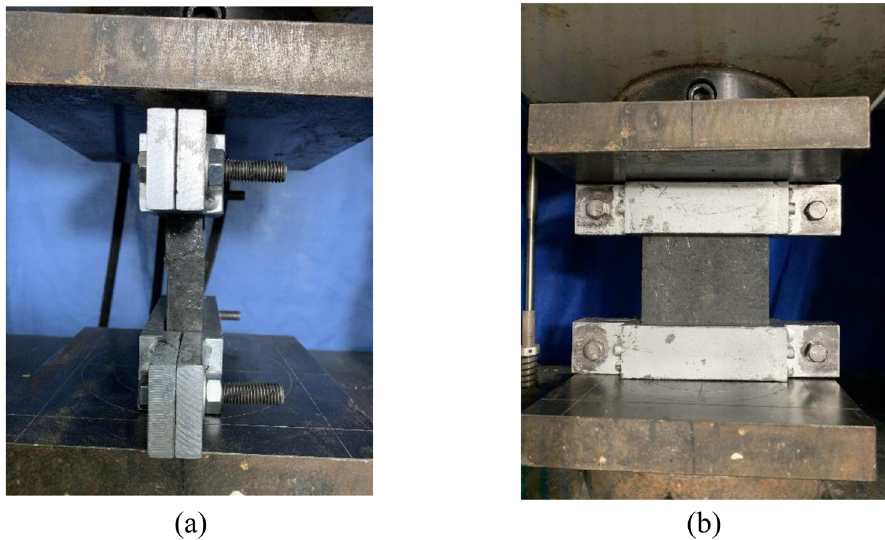
Figure 3: Test setup of edgewise compression: ( a ) side view and ( b ) front